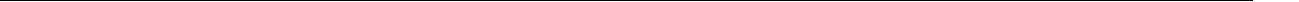
Fig. 4 MANF overexpression in the hypothalamus led to increased body weight and food intake. a Schematic representation of AAV-MANF construct. b A single western blotting analysis of viral MANF expression in different brain regions of 2-month old wild type (WT) mice injected with AAV-MANF into the hypothalamus. c Immuno fl uorescence images of 2-month-old WT mice injected with AAV-GFP or AAV-MANF into the hypothalamus. Green fl uorescence was used to indicate the expression of GFP in different regions of the hypothalamus, including arcuate nucleus (ARC), dorsomedial hypothalamus (DMH) and lateral hypothalamus (LH). Red fl uorescence was used to indicate the expression of MANF, which was stained by an HA antibody. Higher magni fi cation (63×) images revealed cytoplasmic localization of MANF. Nuclear staining is shown in the merged image. Staining of hypothalamus from uninjected mice was used as negative controls ( Scale bar : left 50 μ m, right 10 μ m). d A single image of WT mice 2 weeks after AAV-GFP or AAV-MANF injection. e Body weights of male and female 2-month-old WT mice were measured weekly before and after AAV-GFP or AAV-MANF injection (* P < 0.05, ** P < 0.01, n = 5, two-way ANOVA with Bonferroni post-tests, Male, F = 153.3, P < 0.0001; Female, F = 74.98, P < 0.0001). f Food intake of male and female 2-month-old WT mice were measured weekly before and after AAV-GFP or AAV-MANF injection (** P < 0.01, *** P < 0.001, n = 5, two-way ANOVA with Bonferroni post-tests, Male, F = 204.8, P < 0.0001; Female, F = 524.2, P < 0.0001). Data are represented as mean ±